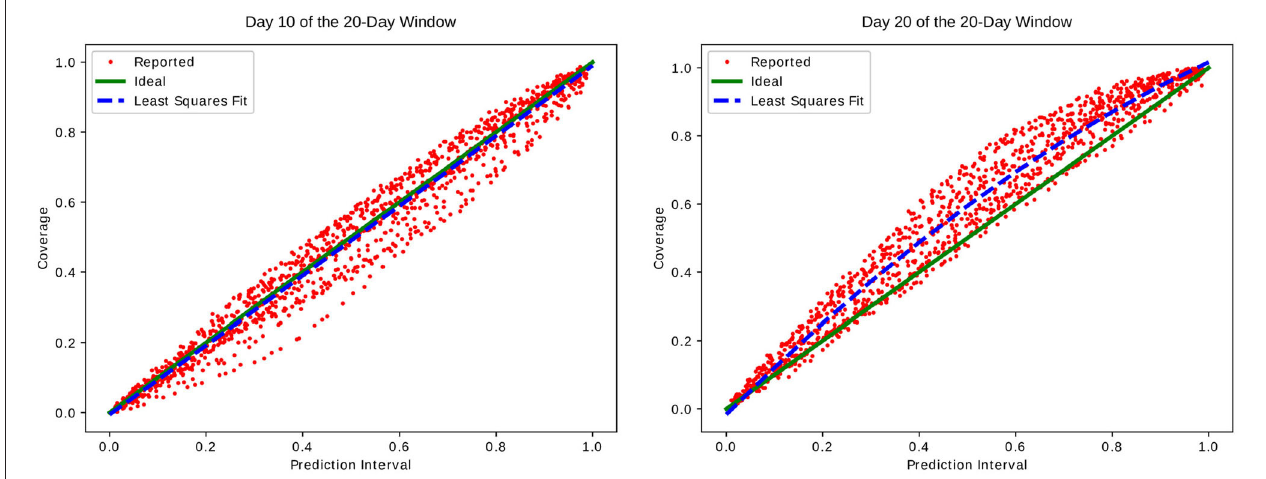
FIGURE 1 | Prediction intervals of incident cases vs. coverage of reported data. Subfigures show this calculated on day 10 and day 20 of each 20-day window W i . We can see that while we have good agreement on day 10 near the middle of each window, day 20 at the end of each window predicts too large of an interval resulting in a higher than expected coverage.